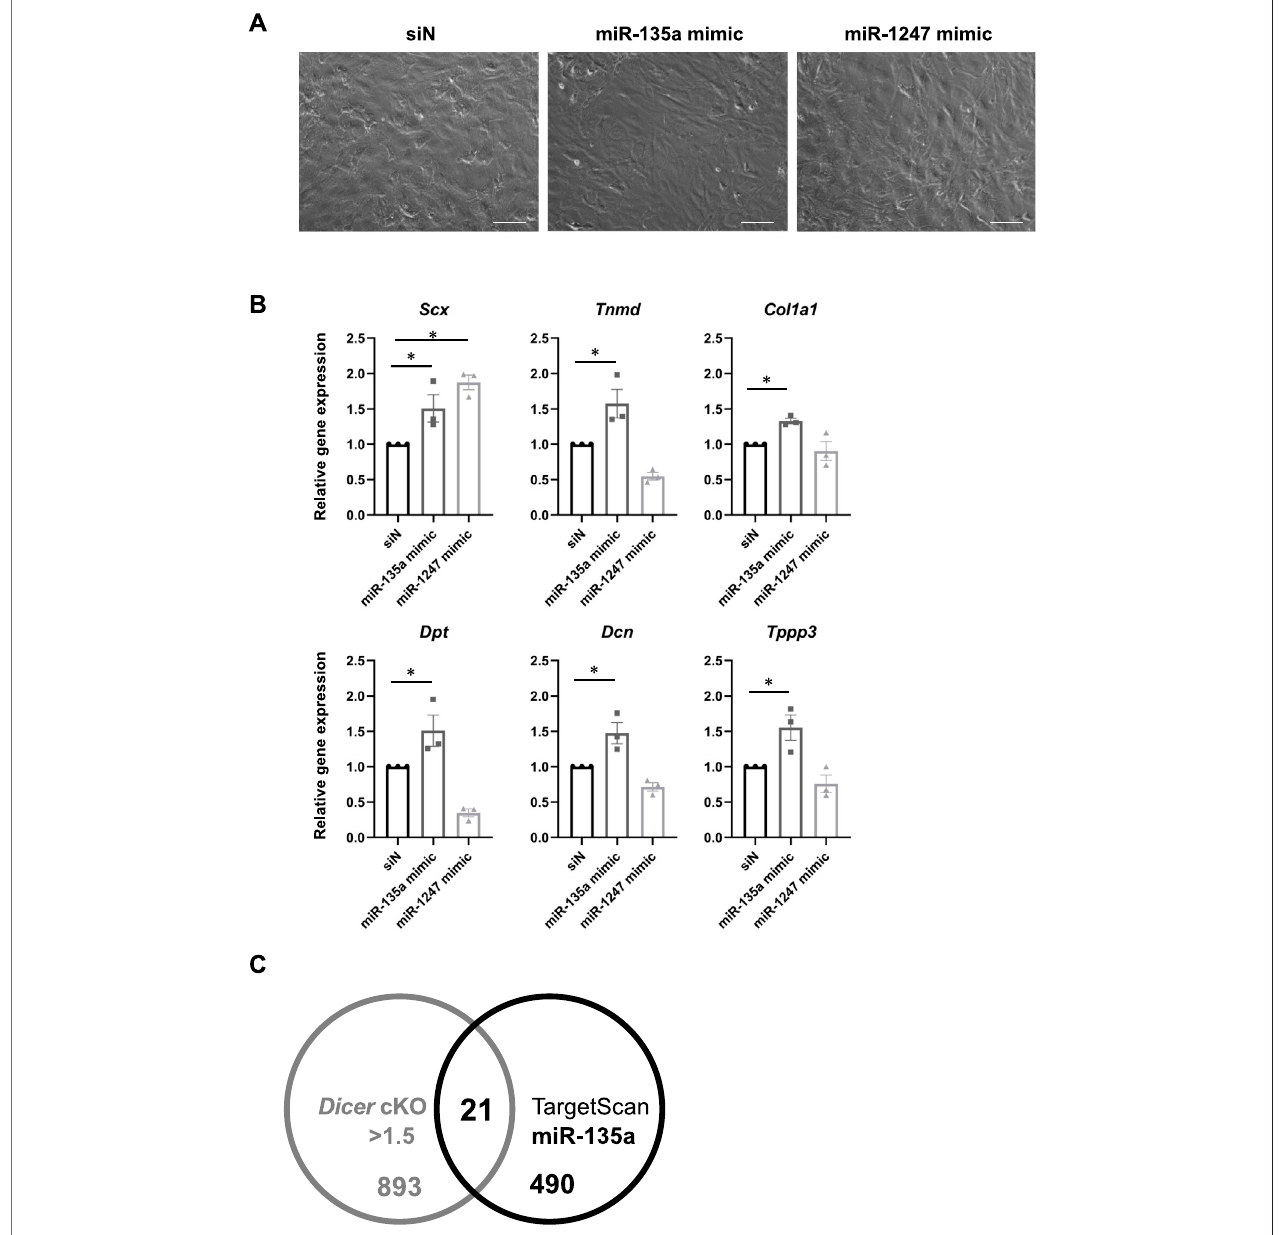
FIGURE 7 | Tendon related-genes expression in injured Achilles tendon-derived fi broblasts with miR-135a mimic. (A) Cell morphology in cultured injured Achilles tendon-derived fi broblasts (iATDF) with miR-135a mimic and miR-1247 mimic (Final 30 nM). (B) The expression of tendon-related genes in iATDF with miR-135a and miR-1247 mimic ( n = 3). (C) Venn diagram comparing upregulated genes in Dicer cKO ( Dicer cKO/Control ratio > 1.5, baseMean > 50 counts) and candidate genes of miR-135ainRNA-seqanalysisandTargetScan.Thedatarepresentedasmean±SEM.ComparisonofgenesexpressionwasperformedusingKruskal-Wallistest; * p < 0.05 versus siN (Control). siN: siRNA negative control. Scale bars: 100 µm.